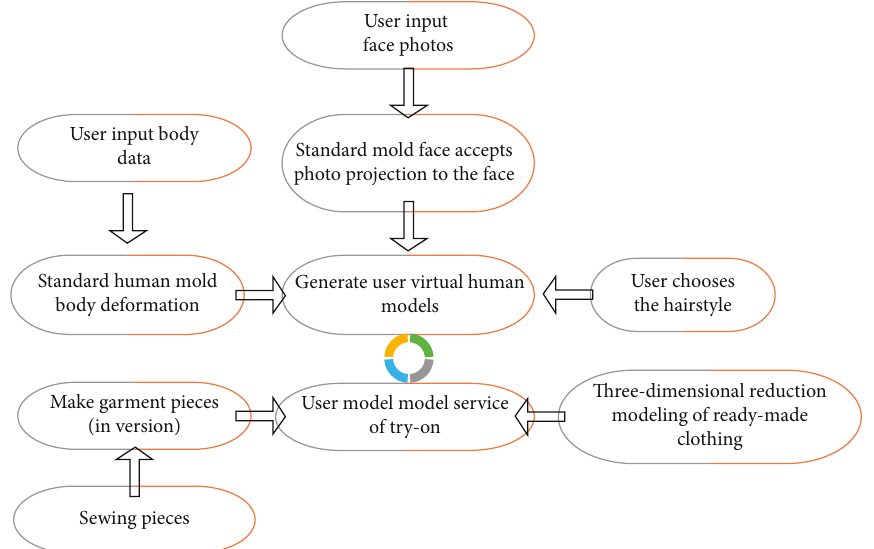
Figure 7: The interactive process of the 3D virtual fitting system.